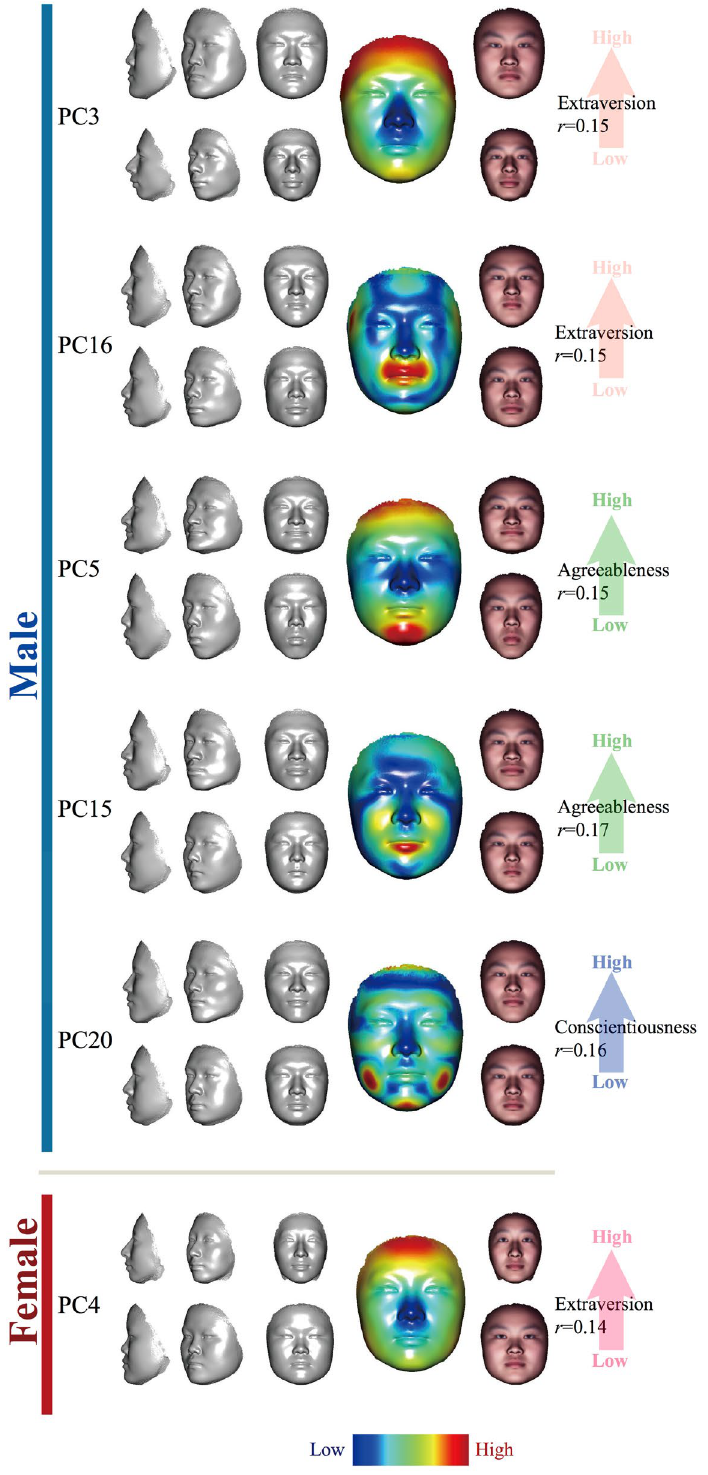
Figure 4. Extracted personality-related feature, which has a significant correlation between predicted score and true score by PCA. From top to bottom are extraversion-related PC3 and PC16 in males, agreeableness-related PC5 and PC15 in males, conscientiousness-related PC 20 in males, extraversion-related PC14 in females. For each panel, the upper faces are created by adding five standard deviations of the projected samples to the mean face; the lower faces are created by subtracting the standard deviation of the projected samples to the mean face. From left to right are faces rotated by 90°, 45°, and 0°. The bigger face next is the mean face, on which the heat colours represent the norm value of PCA at each vertex. At the right side of the mean face are two faces the same as the faces at the left side of the mean face, but with a texture generated from the sample mean